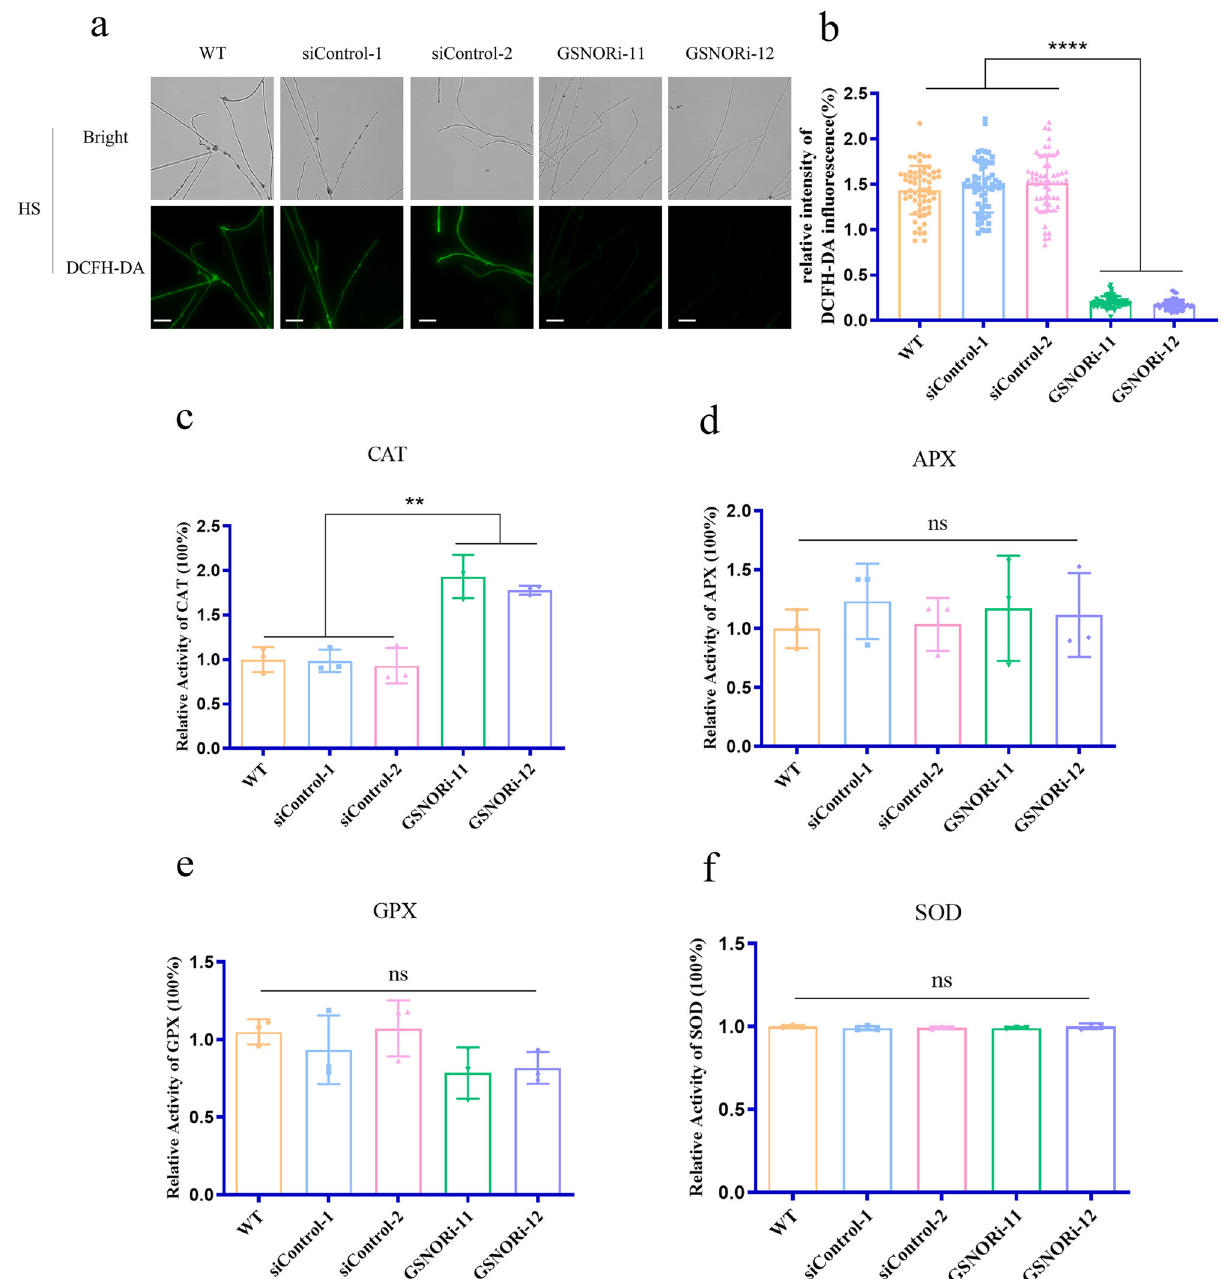
Fig. 2 ROS content and major antioxidant enzyme activity in the WT and GSNOR-silenced strains under HS conditions. a Coverslips were placed on the bottom of Petri dishes; when the WT and GSNOR-silenced strains cultured on mycelium grew over the coverslips, they were exposed to 42 °C for 20 min. The ROS content was detected by staining with DCFH-DA. Scale bar, 100 μ m. b Relative ROS content in the WT and GSNOR-silenced strains treated with HS. The WT and GSNOR-silenced strains were cultured for 5 days at 28 °C, then exposed to 42 °C for 20 min. c – f The CAT ( c ), APX ( d ), GPX ( e ), and SOD ( f ) activity was measured in the WT and GSNOR-silenced strains under HS conditions. Data are presented as the mean ± SD of data from